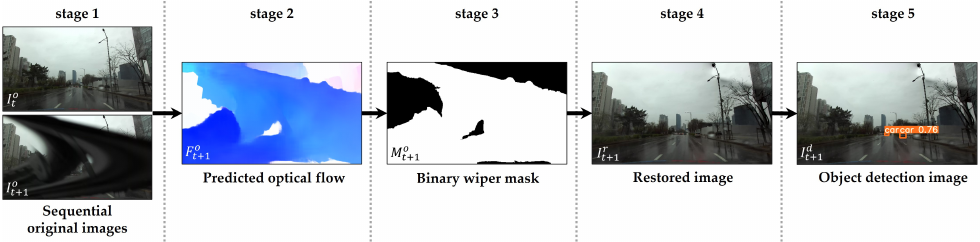
) ; , I o t t + 1 ) ; ( stage 4 ) restores t + 1 ) . Best t + 1